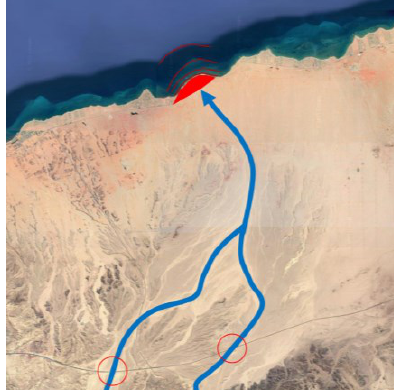
Figure 10. Example of the potential hazard of flash